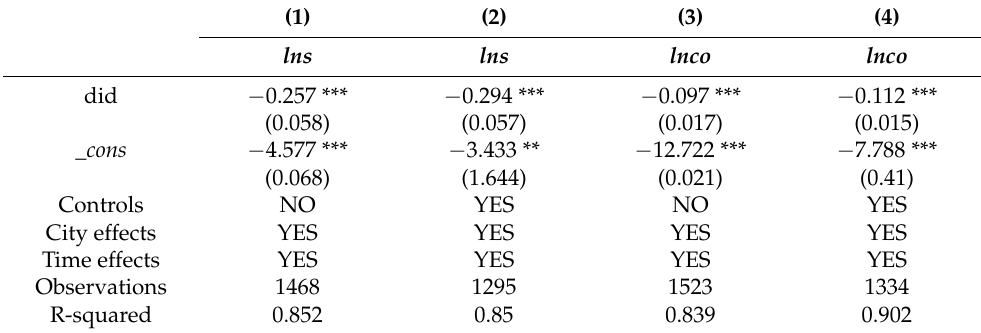
Table 6. ETZs to EIPs.